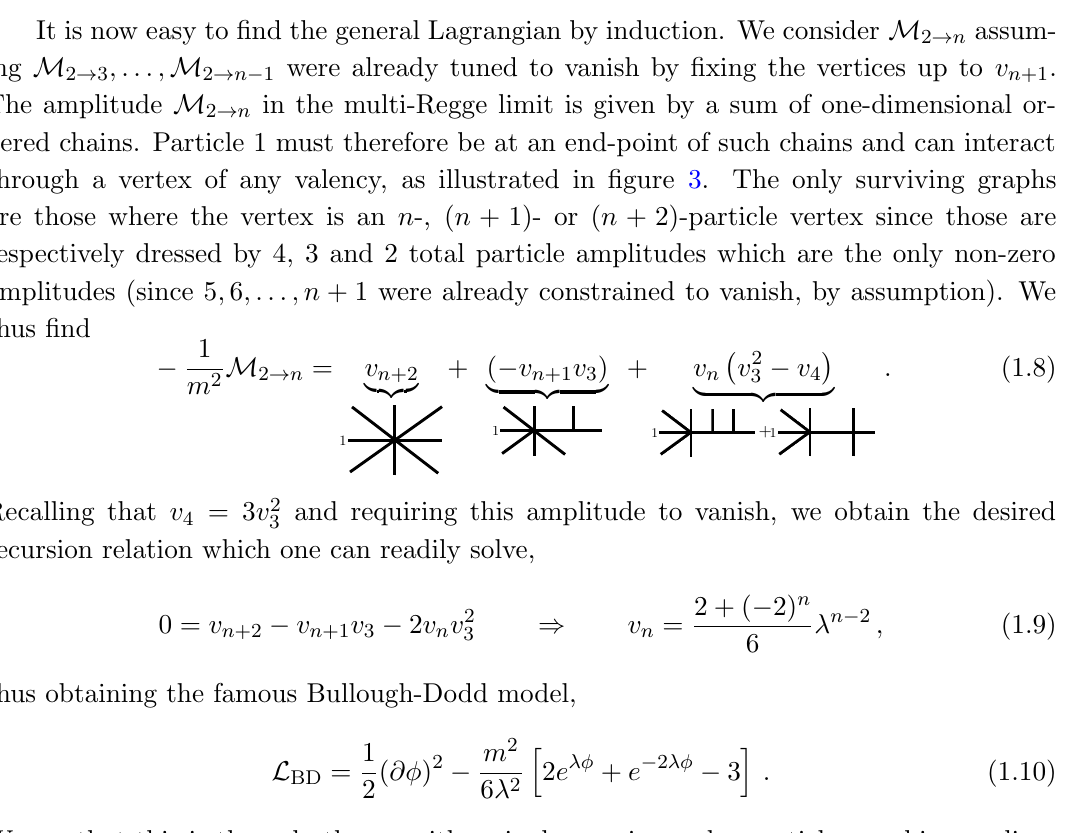
Figure 3 . We organize all ordered diagrams so that particle 1 is always on the left. The sum of diagrams where particle 1 is attached to a k -point vertex with k < n evaluates to zero since it is attached to a total amplitude with n k + 4 > 4 external particles. As a result, only the three (cid:0) contributions in the last row